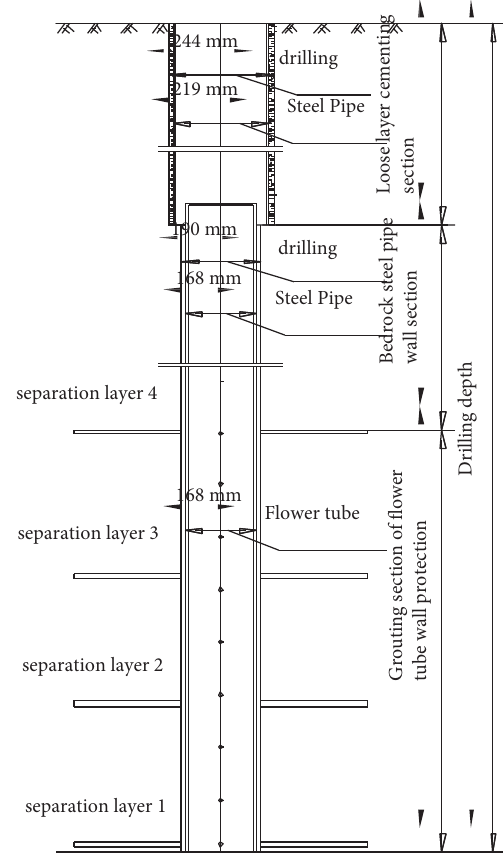
Figure 10: Schematic diagram of the grouting borehole structure of each fully mechanized caving face in the second mining